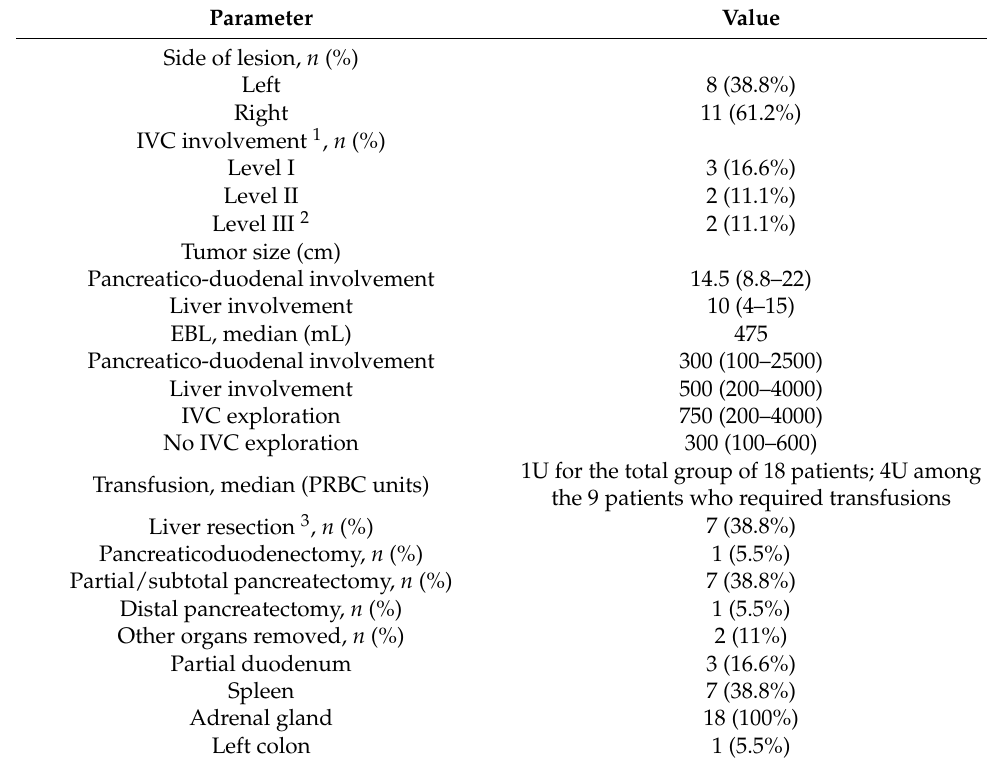
Table 2. Operative details and outcomes.